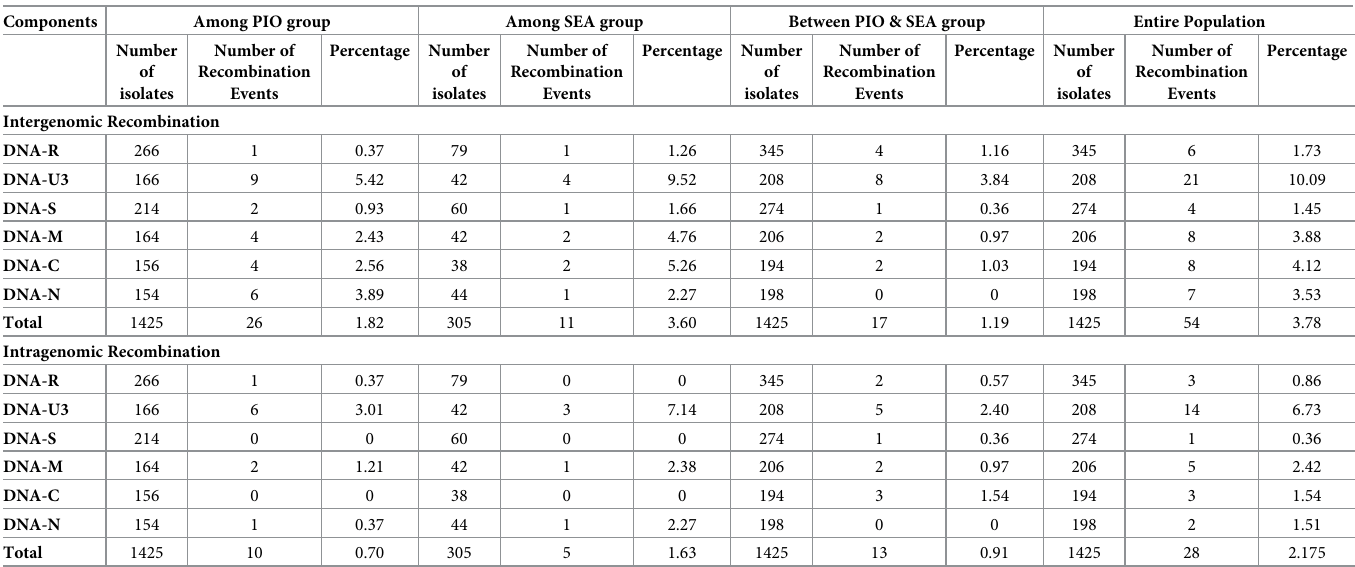
Table 7. Occurrence of recombination in Banana bunchy top virus